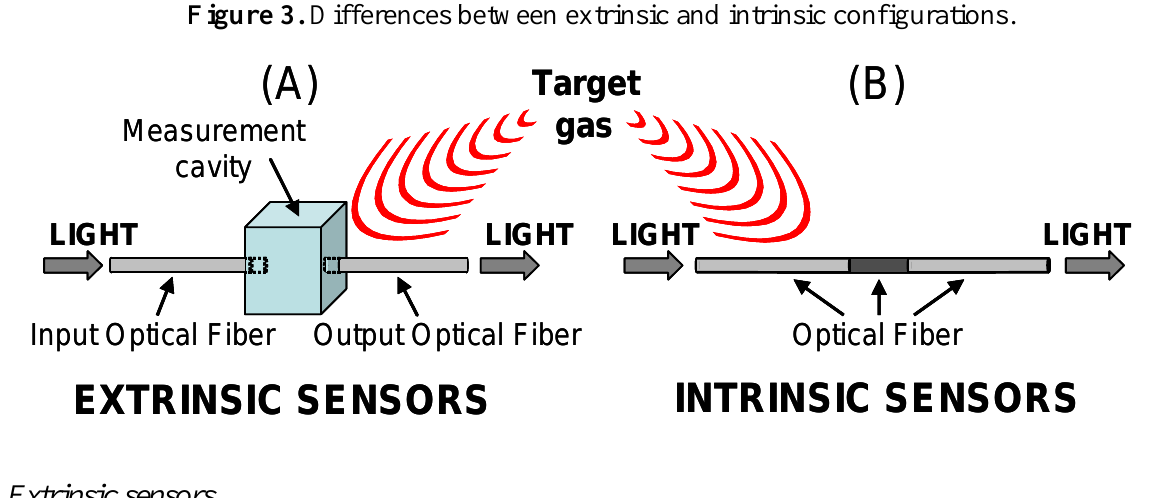
Figure 3. Differences between extrinsic and intrinsic